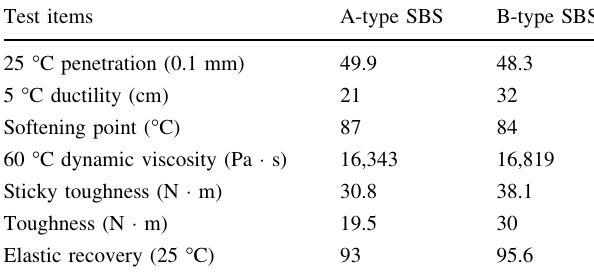
Table 4 Properties of high-viscosity additive (HVA)